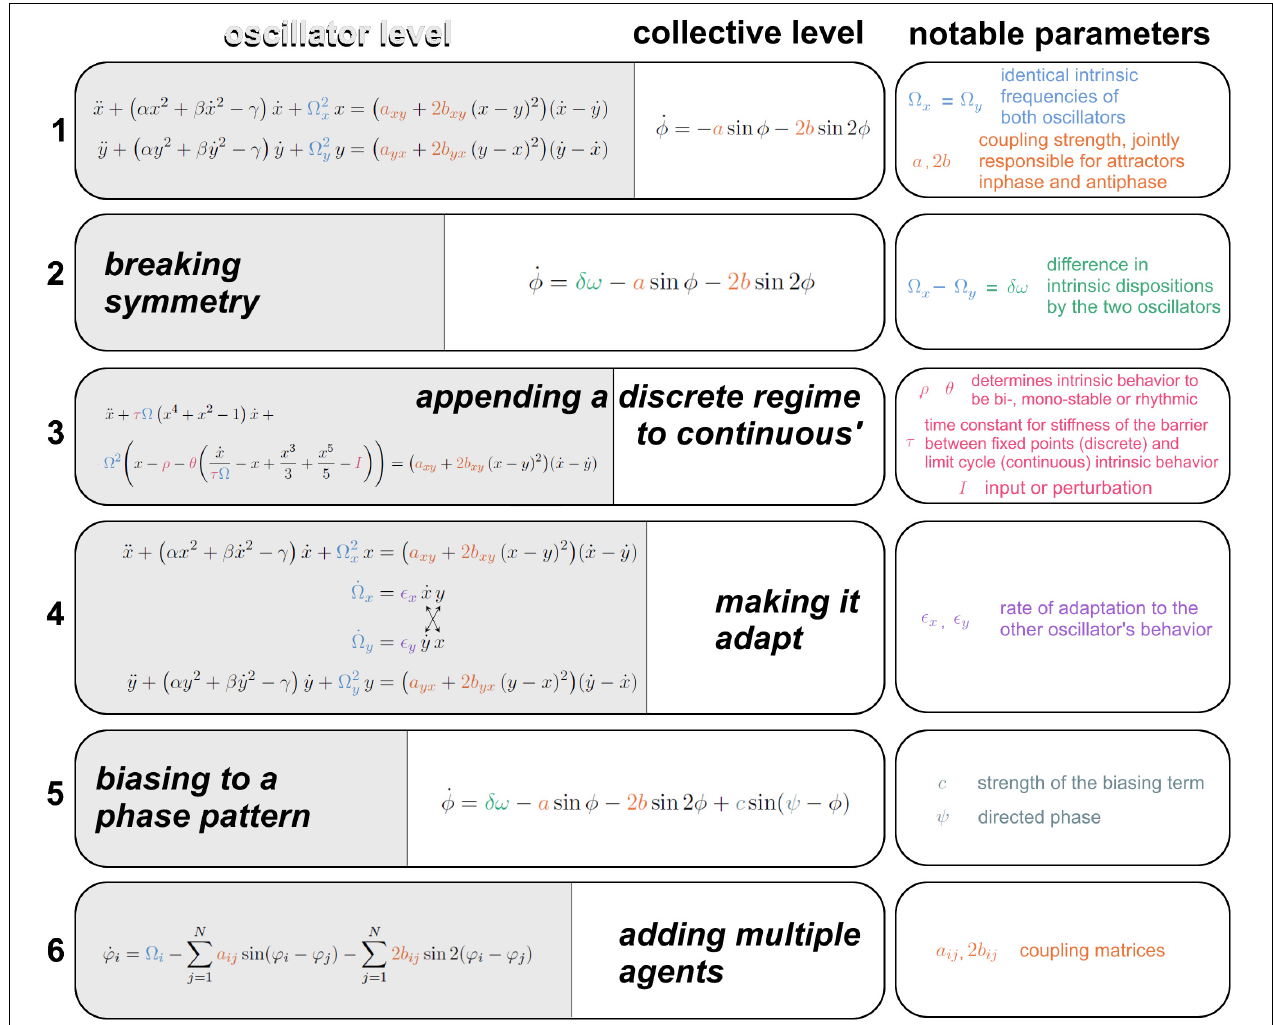
FIGURE 4 | Augmentations of the HKB model toward increasing life-like relevance. (1) The first equation is spelled out at the oscillator level on the left (specifying the position, velocity and acceleration of oscillators x and y, with notable parameter (cid:127) carrying the intrinsic frequency, see “Introduction” for motivation); and at a collective level on the right (specifying the rate of change of x and y’s relative phase φ . The coupling strength parameters a and b are responsible for the bistability of inphase and antiphase. (2) A symmetry breaking term δω (Kelso et al., 1990) gives rise to metastability. (3) A modification to the oscillators’ dynamics supplies regimes with discrete behavior -excursion from rest- and continuous cyclical behavior in a single formalism (Jirsa and Kelso, 2005), whose topology is controlled by three parameters ρ , θ , and τ . Transitions between regimes are autonomously followed in a human-machine interaction (Dumas et al., 2014). (4) The intrinsic dynamics of the oscillators (cid:127) is coupled with adaptation rate (cid:101) for partners to adapt their more stable behavioral dispositions as they interact (Nordham et al., 2018). (5) A bias parameter (cid:57) is introduced to direct the coordination to pull human-machine dyads away from their spontaneous attractors with strength c (Dumas et al., 2014). (6) A scalable multiagent system of equations is built upon empirical data (Zhang et al., 2019) that carries the first and second order coupling term just like the original HKB model from eq. 1, under coupling matrices a and b. See references in